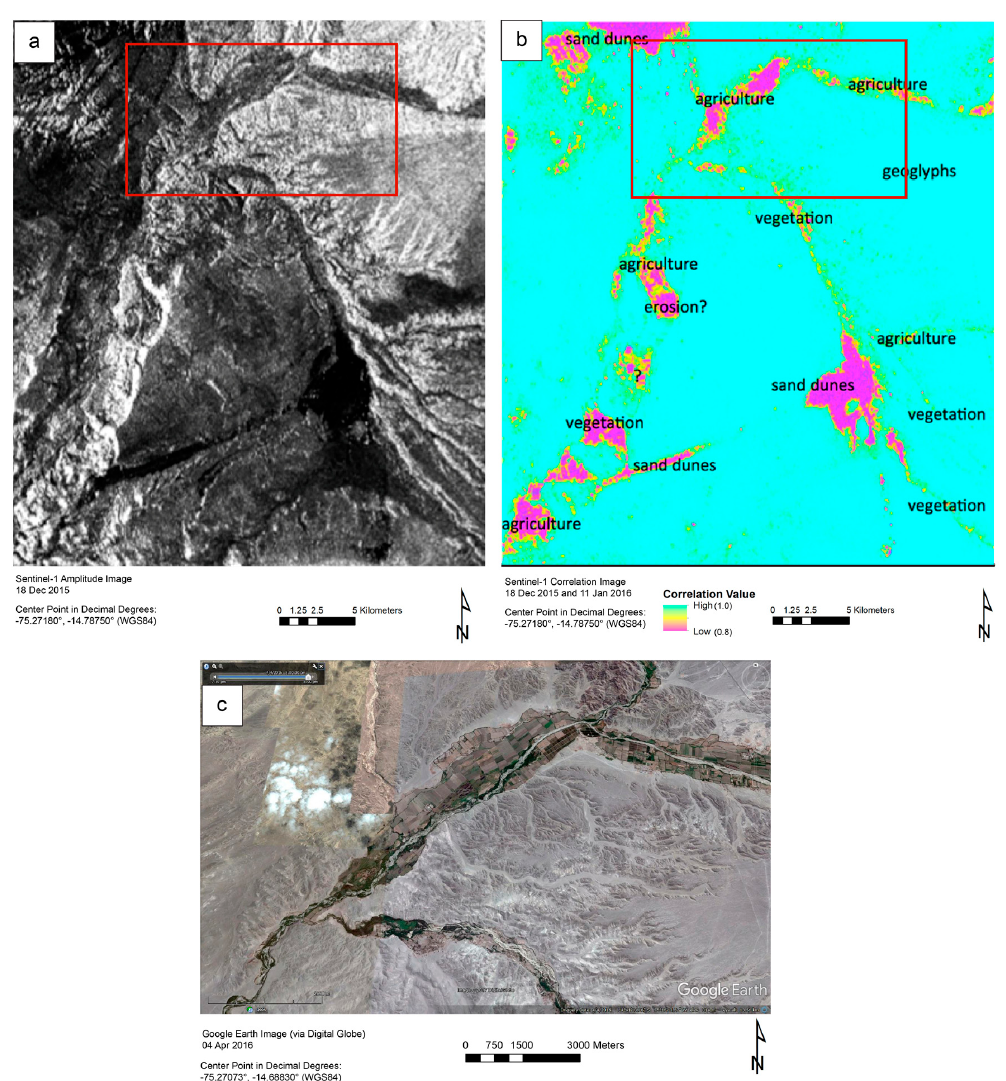
Figure 5. Panel ( a ) shows a Sentinel-1 amplitude image created using data collected on 18 December 2015. While many large landscape features are discernible here, the correlation image in ( b );